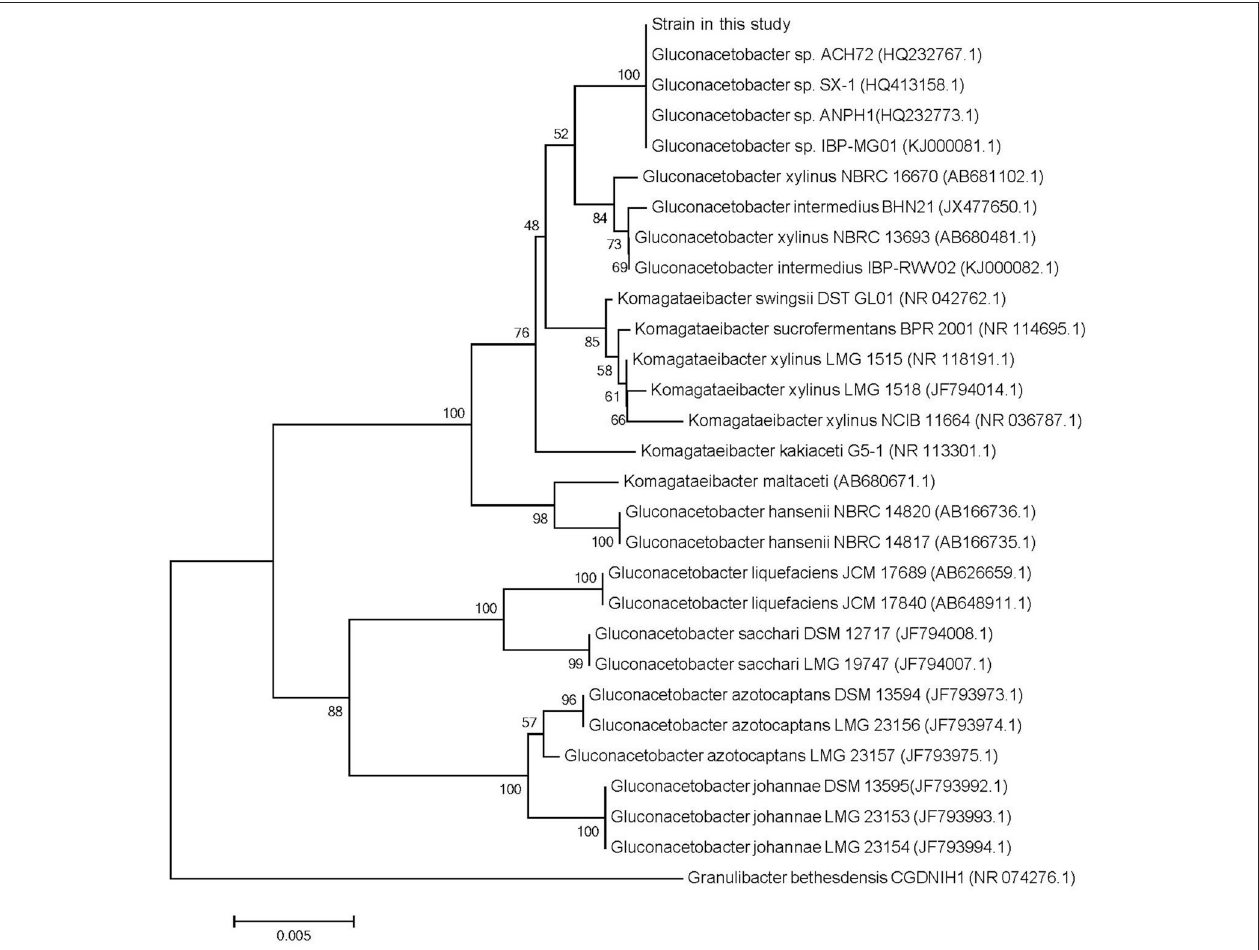
FIGURE 1 | A phylogenetic tree based on 16S rRNA gene sequences for Gluconacetobacter sp. and Komagataeibacter sp. The phylogenetic tree derived from the neighbor-joining methode was newly constructed ( Yamada et al., 2012). The type strain of Granulibacter bethesdensis (HR 074276.1) was used as an outgroup. The numberals at the respective branching points indicate bootstrap values (%) based on 1000